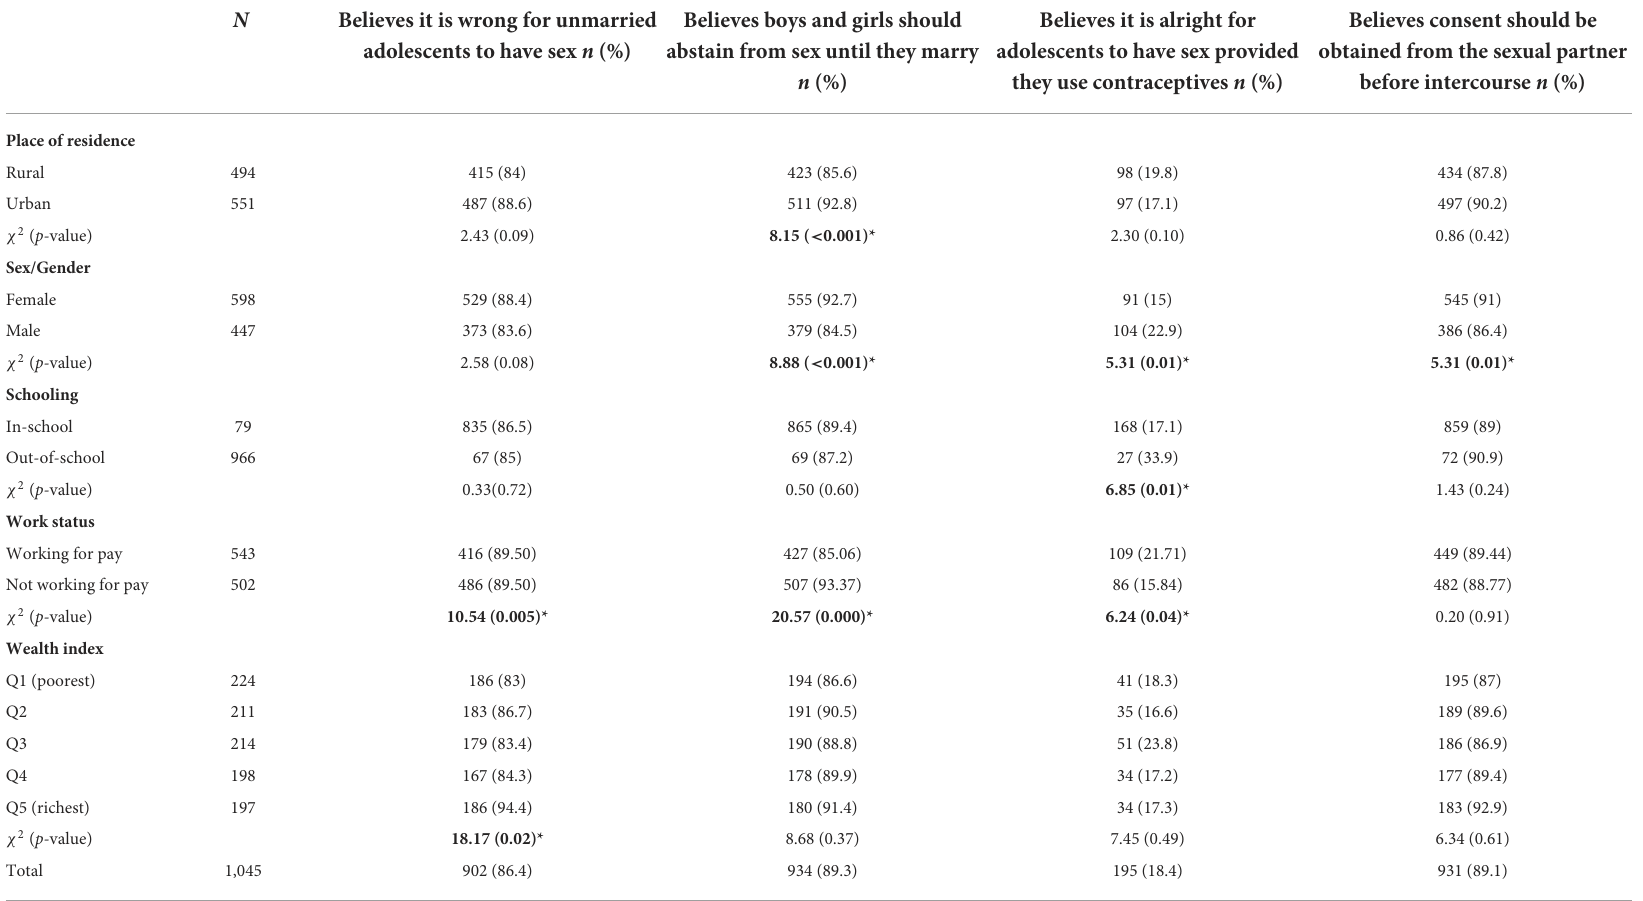
TABLE 3 Socio-demographic disaggregation of ideologies about adolescent